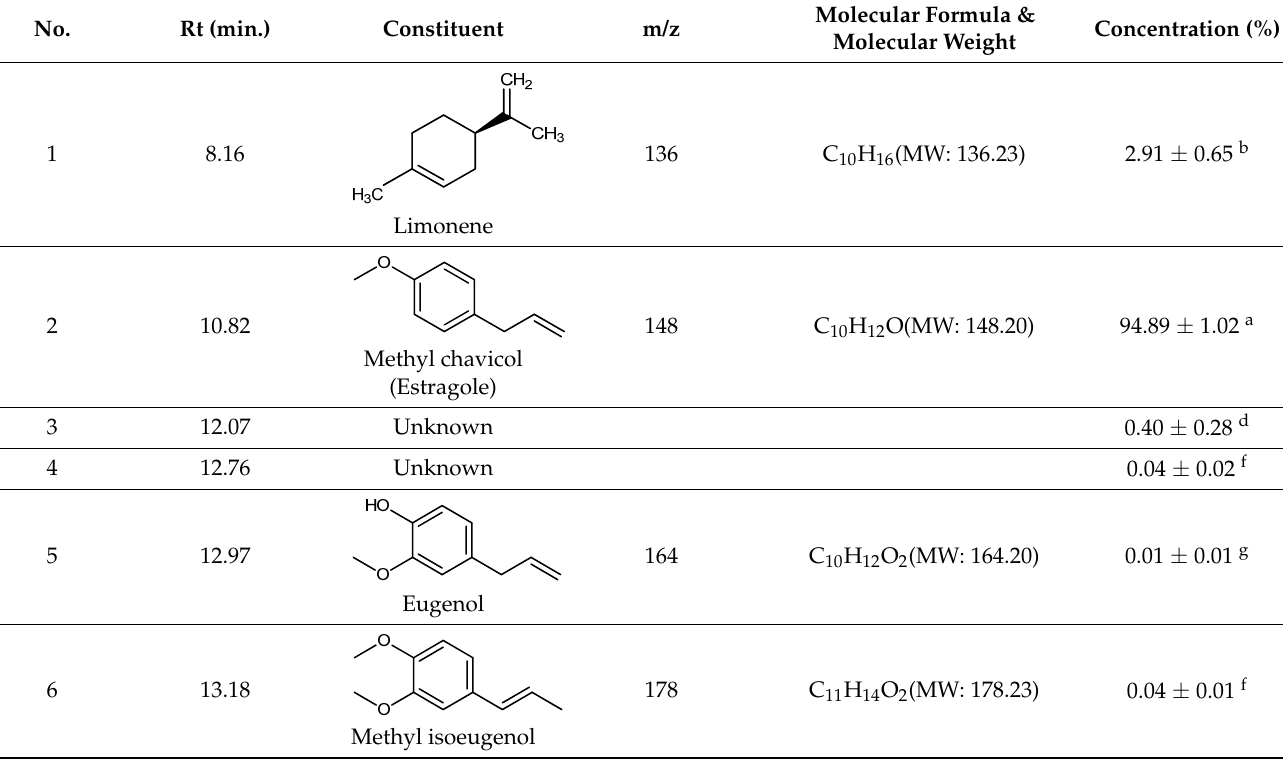
Table 1. The chemical composition of the EO from A. foeniculum AdB.